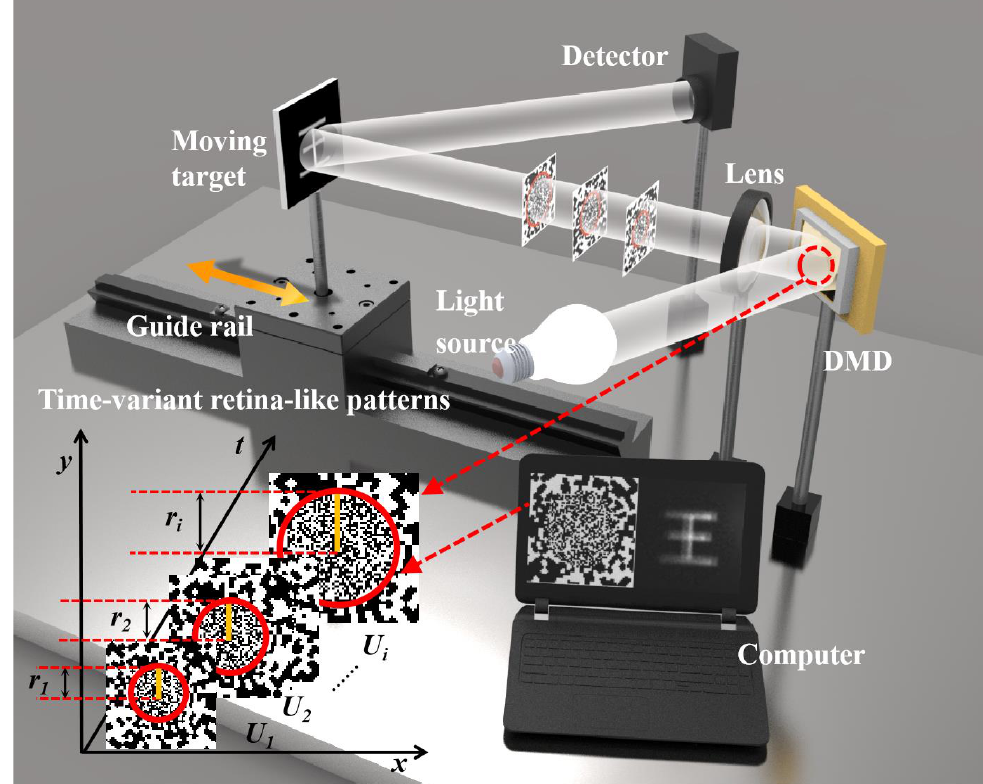
Figure 1. Experimental setup.